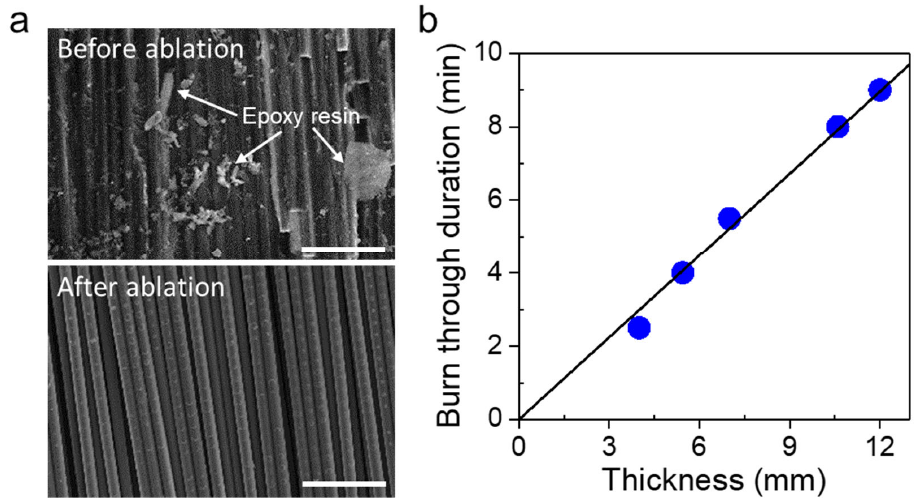
Figure 3. ( a ) SEM images of fibers in the panels before and after the burning process (scale bar is 50 μ m). ( b ) Burn ‐ through duration as a function of panel thickness (blue dots) captured by a linear fit (solid line).